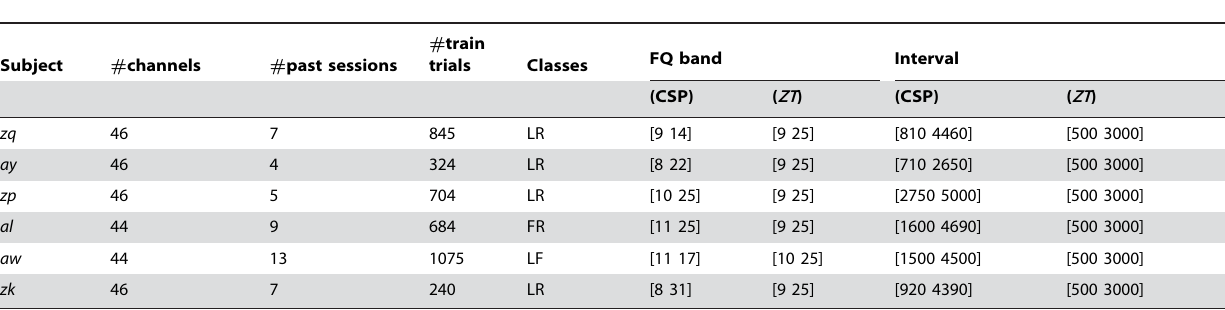
Table 1. Subject-specific